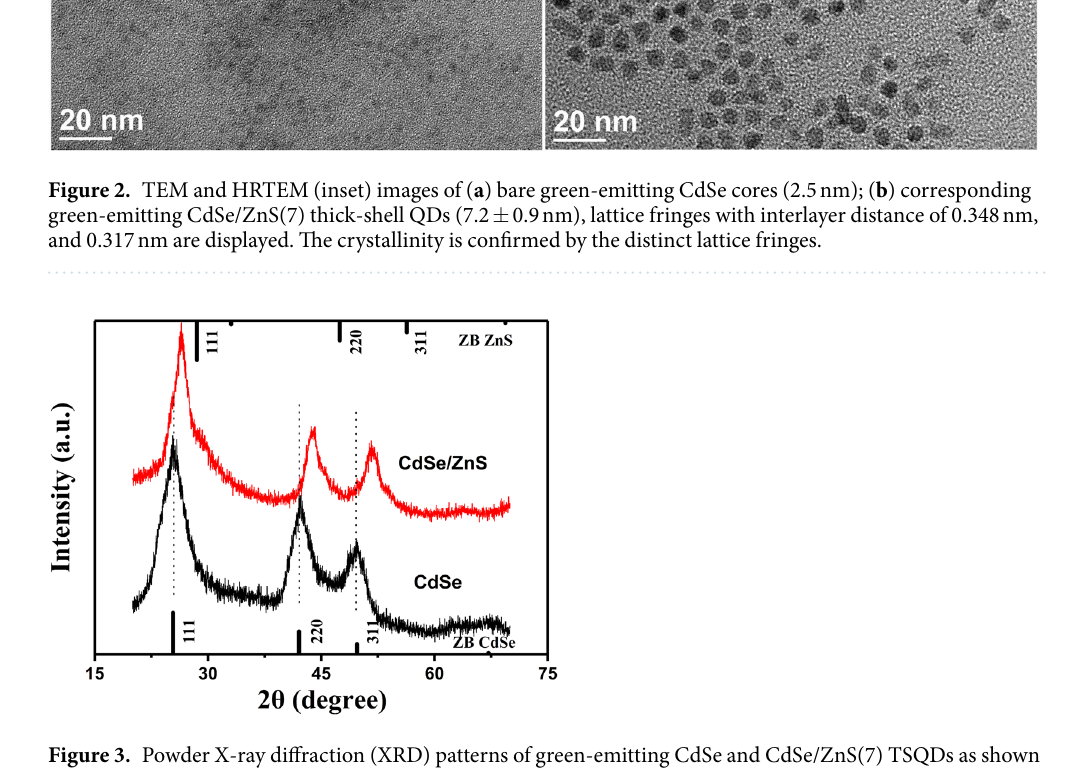
Figure 3. Powder X-ray diffraction (XRD) patterns of green-emitting CdSe and CdSe/ZnS(7) TSQDs as shown in Fig. 2. The XRD peaks position of the zinc blende (ZB) bulk CdSe (JCPDS No. No. 00-019-0191) and bulk ZnS (JCPDS No. 80-0020) are respectively indicated by vertical solid lines below and above. Dash lines are a guide to the